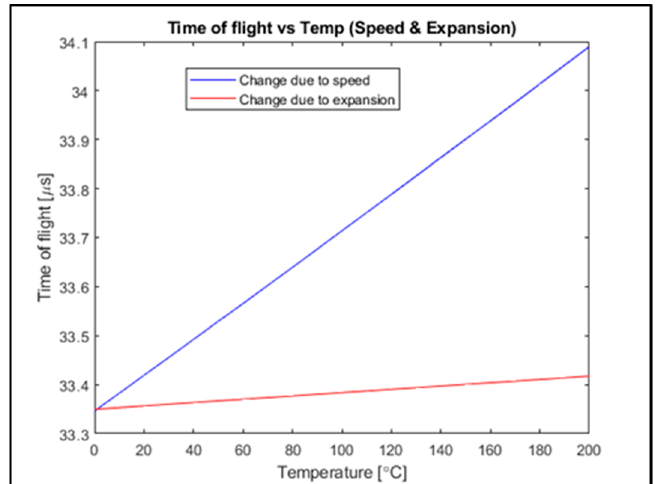
Figure 3. Effect of change in speed and expansion on tof .